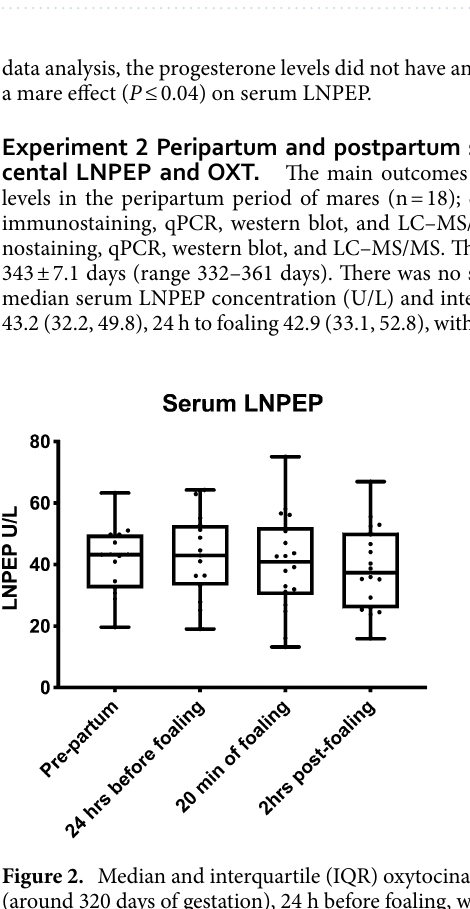
Figure 1. Serum progesterone (ng/ml) (upper panel) and oxytocinase (LNPEP) (U/L) (lower panel) of each individual animal in non-pregnant (n = 5) (grey) and pregnant mares (n = 6) (black) from the Day of ovulation (0) to 22. Differences ( p ≤ 0.05) at the various time points between groups are indicated by stars.